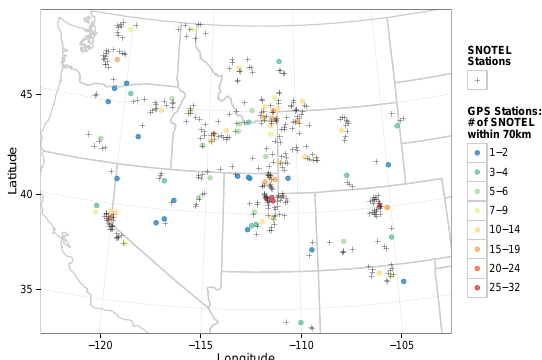
Fig. 3. Data used in this study come from the SNOTEL sites shown in this figure. SNOTEL sites were selected if they were within 70km of GPS snow depth stations. The number of SNOTEL sites within this radius of each GPS station is shown. Three GPS stations in Alaska, each with 1–2 associated SNOTEL sites, are not